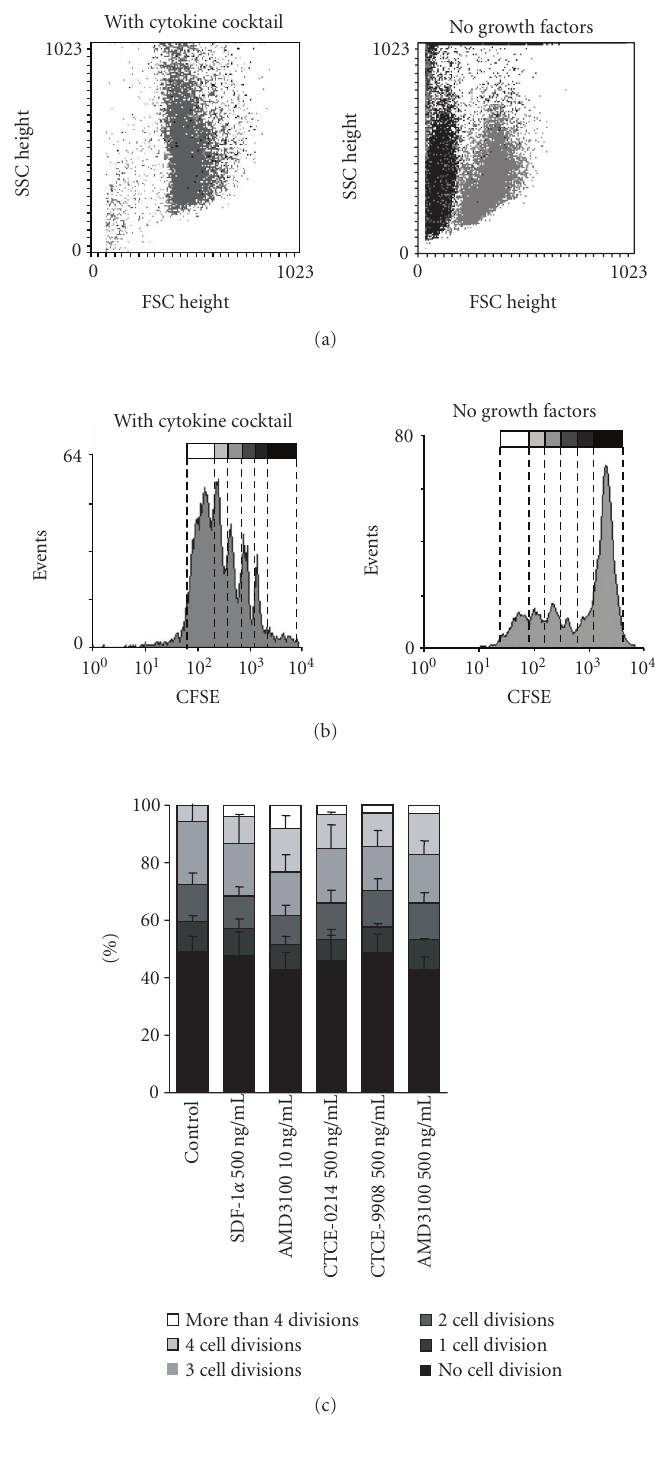
Figure 3: E ff ects on Proliferation. CD34 + cells were stained with CFSE and subsequently grown for 5 days in culture medium with a cytokine cocktail (Epo, IL-3, IL-6, GM-CSF, SCF, bFGF, and IGF-1) or for 7 days in culture medium without cytokine supplements. Cultivation with the cytokine cocktail resulted in a very high viability of > 95%, whereas without cytokines the cell population could be distinguished accord- ing to forward scatter (FSC) and side scatter (SSC) from cell fragments (black spots: PI positive; grey spots: PI negative). (a) The number of cell divisions was estimated within the PI negative cell population by the dilution of CFSE dye. Whereas the CD34 + cells demonstrated a high proliferation with the cytokine cocktail, only about 50% of the cells proliferated without these cytokines. (b) SDF-1 α , the peptide agonist CTCE-0214, the peptide antagonist CTCE-9908, and the nonpeptide antagonist AMD3100 did not have a significant e ff ect on the fraction of proliferating cells (c) nor on the percentage of PI negative cells (three independent